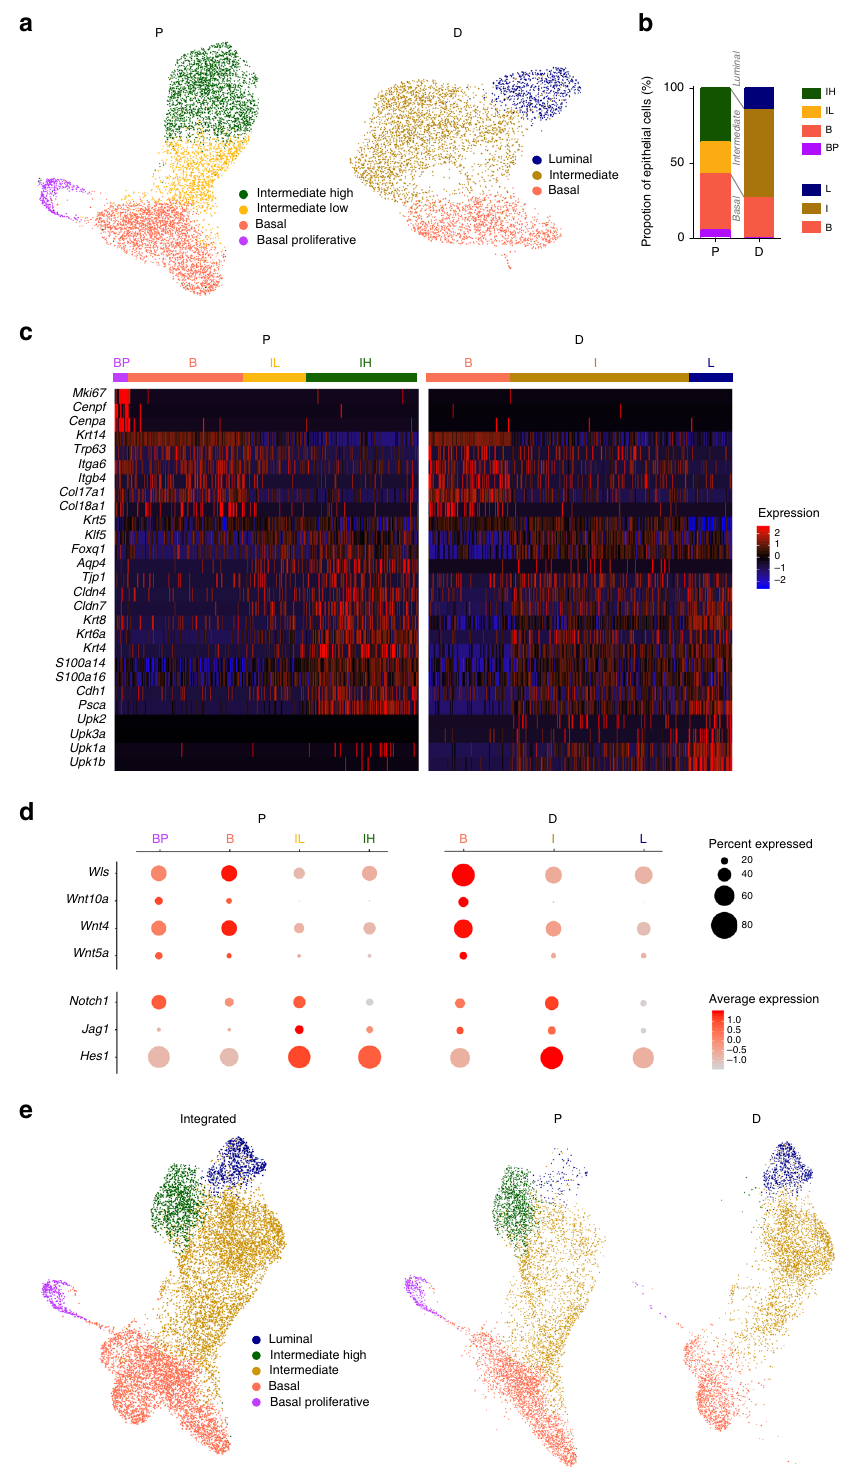
Fig. 8 Single-cell RNAseq reveals distinct cell populations within P and D organoids. a Transcriptomic clusters in P ( n = 6826 cells) and D ( n = 4896 cells) organoids visualized using uniform manifold approximation and projection (uMAP) plots, colored according to cluster. b Proportion of cells from P and D organoids contributing to each of the clusters shown in panel a . c Heatmap depicting expression of selected cluster markers identi fi ed by differential expression analysis (Wilcoxon rank-sum test). d Dot plot depicting the expression of signi fi cantly differentially expressed genes from the Wnt and Notch signaling pathways in P and D organoids, according to cell clusters. e UMAP plots visualizing integrated analysis of cells from P and D organoids as a joint plot (left, n = 11722) or separate plots (P, center; D, right). For P organoids: B (Basal), BP (Basal-Proliferative), IL (Intermediate-Low) and IH (Intermediate- High); for D organoids: B (Basal), I (Intermediate), and L (Luminal). Source data are provided as a Source Data fi